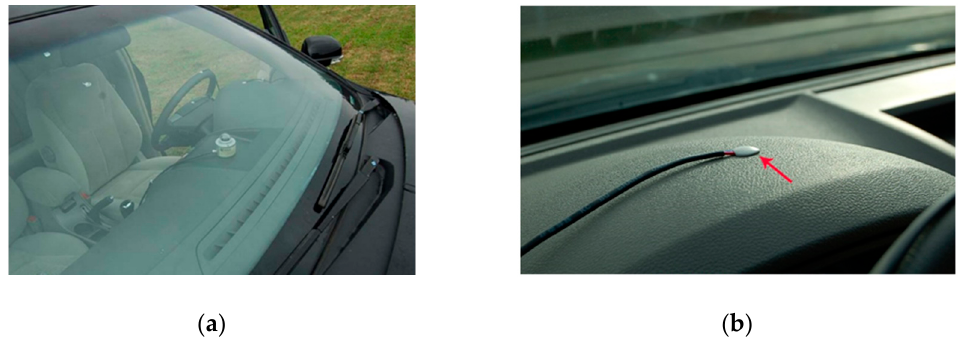
Figure 2. Radiation and temperature sensors: ( a ) solar radiation in the cabin; and ( b ) dashboard temperature.